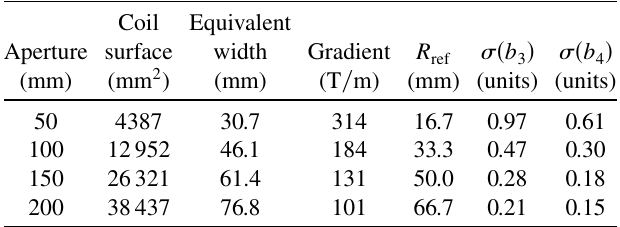
TABLE III. Features of four coil layouts, and expected b b rms based on a Monte Carlo with random movements of 4